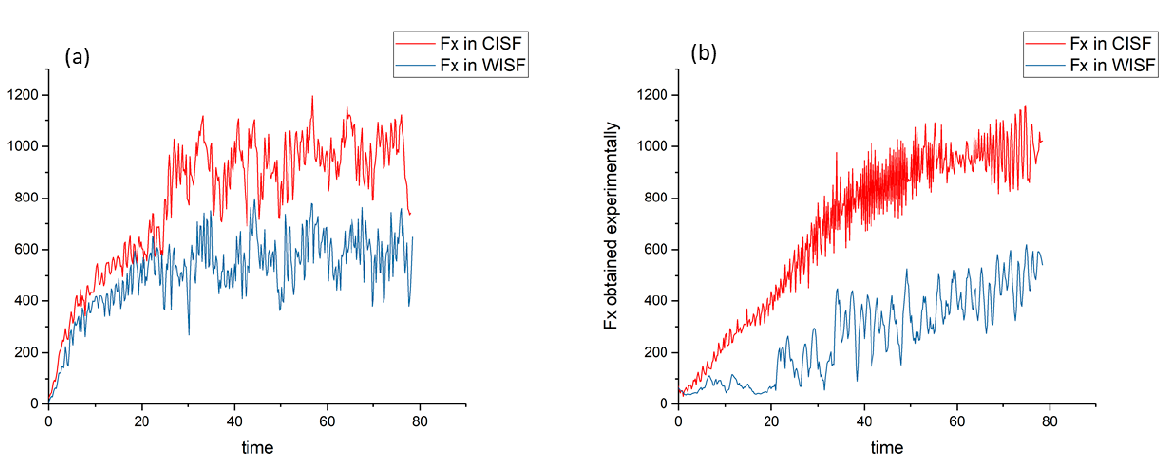
Figure 9. Comparison of X-component of forming force: ( a ) comparison of F x in FEA modeling and ( b ) comparison of F x obtained experimentally.